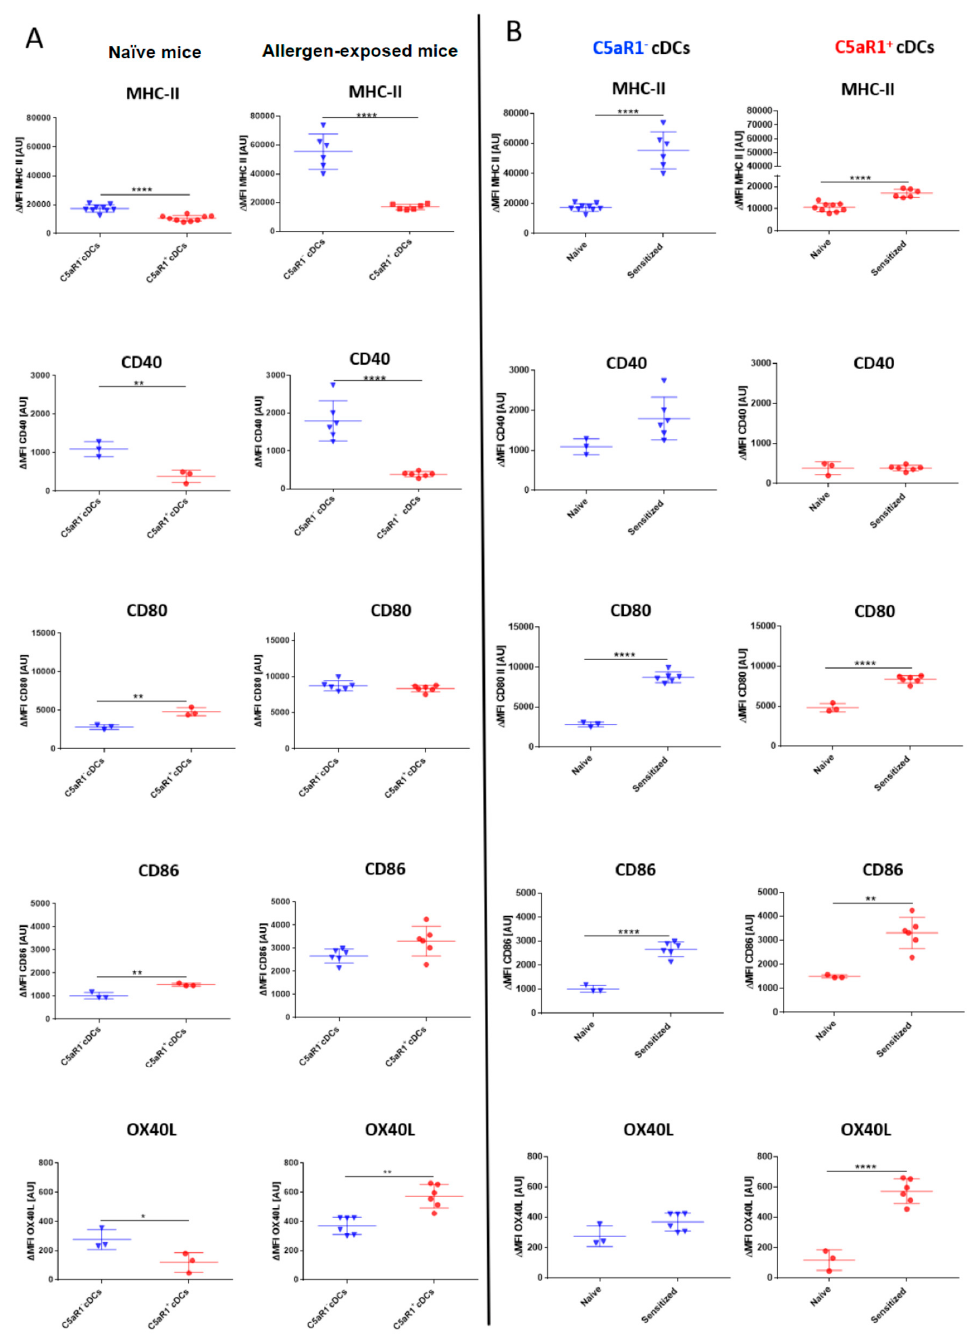
Figure 3. Association of C5aR1 expression on CD11b + cDCs with MHC-II, CD40, CD80, CD86 and OX40L in naïve and HDM / OVA-immunized mice. ( A ) Costimulatory molecule expression in cDCs from either naïve WT mice (left panel) or WT mice treated once i.t. with a mixture of HDM / OVA (100 µ g / 40 µ g) (right panel). Twenty-four hours after the in vivo treatment, the expression of MHC-II and the co-stimulatory molecules CD40, CD80, CD86, and OX40L was evaluated by measuring 10,000 events for each of the two subpopulations. ( B ) Comparison of MHC-II and costimulatory expression levels before and after treatment with HDM / OVA (100 µ g / 40 µ g) in C5aR1 − cDCs (left panel) and C5aR1 + cDCs (right panel). Shown is the ∆ MFI of the expression levels of the examined molecules by the two subsets as mean ± SEM; the ∆ MFI is defined as the mean fluorescence intensity of the signal normalized to the FMO control; n = 3–6 per group; di ff erences between groups were evaluated by unpaired t-test, * p < 0.05; ** p < 0.01; **** p <